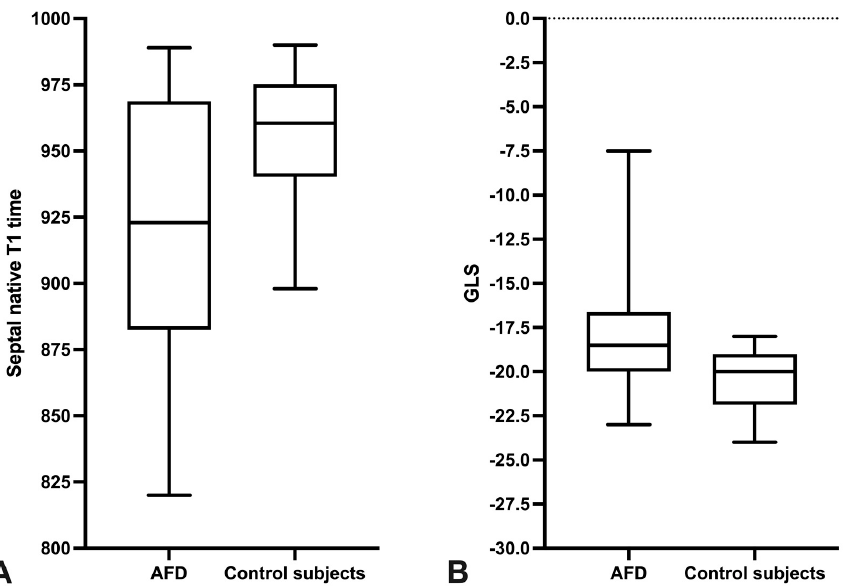
Figure 2. Septal native T1 times and GLS in FD patients and control subjects. The boxplots present the septal native T1 times ( A ) and the global longitudinal strain (GLS) ( B ) in FD patients and in control subjects. Table 2. Cardiac function and morphology: FD versus control group.